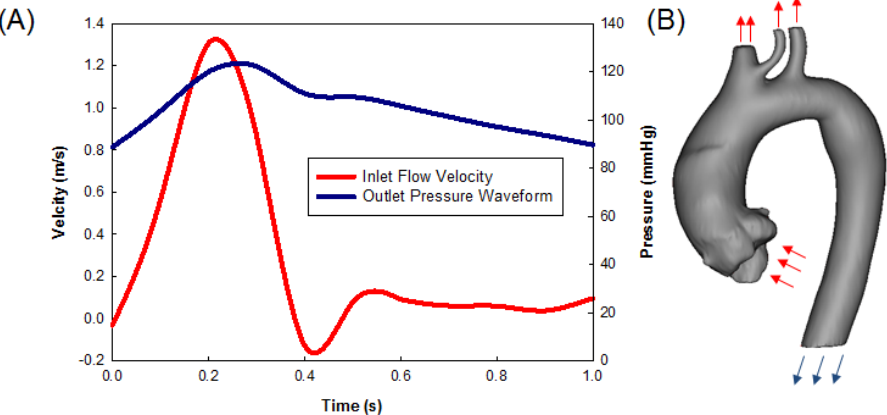
Figure 2. ( A ) Pre-operative inlet flow rate and outlet pressure waveforms and ( B ) boundary conditions prescribed in the model, with inlet velocity waveform for the aortic inlet and each of the supra-aortic arteries (as scaled versions of the aortic inlet), as well as outlet pressure waveform at the distal descending aorta .